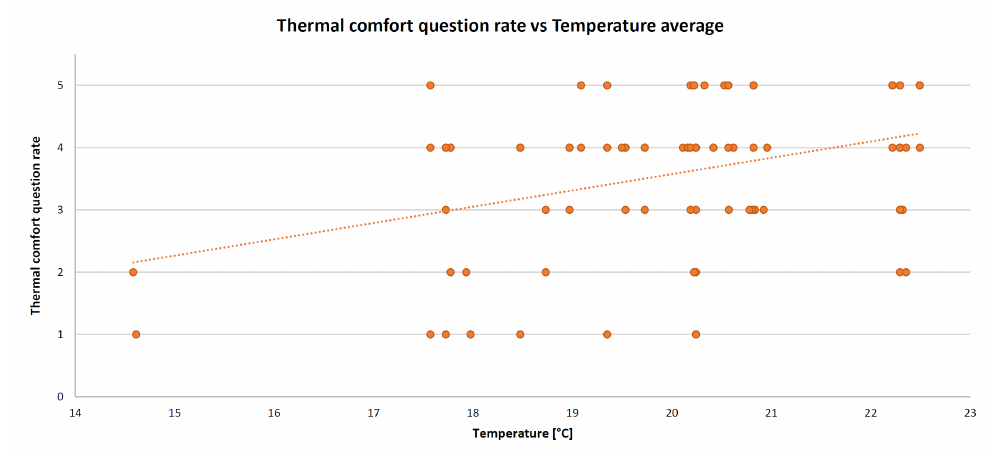
Figure 12. Thermal comfort XY scatter plot and trend